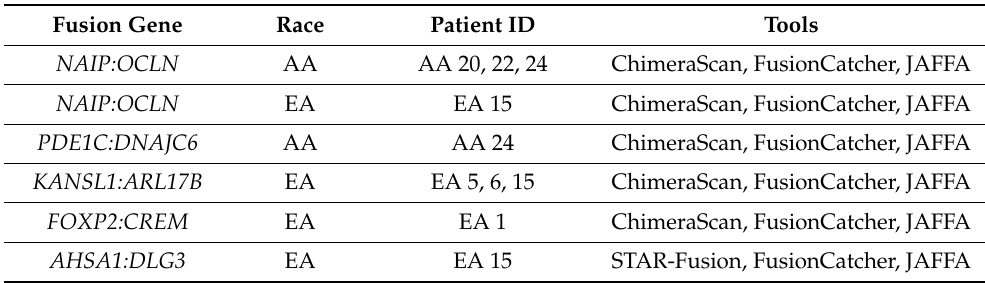
Table 5. Novel predicted fusion genes identified by each tool. Race, patient samples, and the tools used to obtain the fusions are